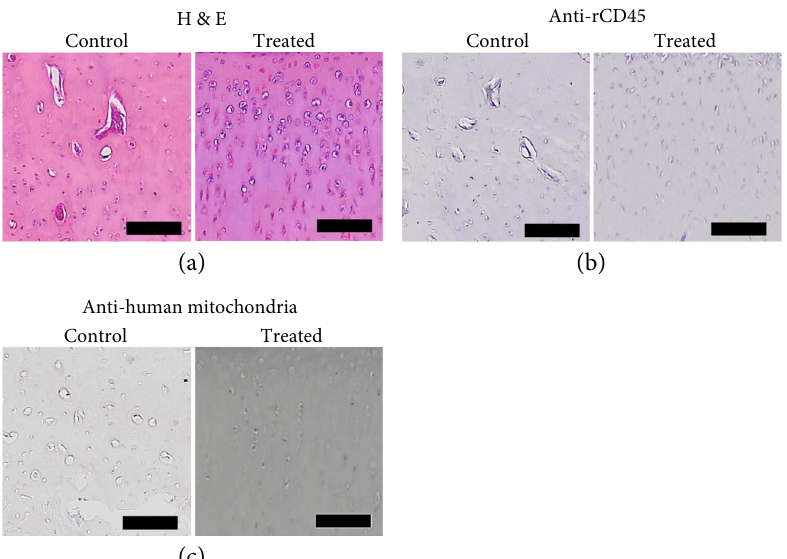
Figure 11: The histology and immunohistochemistry of the iPSC-MSC-chondrocytes transplanted cartilage. (a) H & E staining of control and treated cartilage. The control cartilage was more destructive than treated cartilage. (b) The IHC of rCD45. There was no staining of rCD45 in both groups. (c) Anti-human mitochondria staining of the cartilage with or without transplanted iPSC-MSC-chondrocytes. There was no staining of anti-human mitochondria in treated cartilage. Scale bar = 100 μ m .